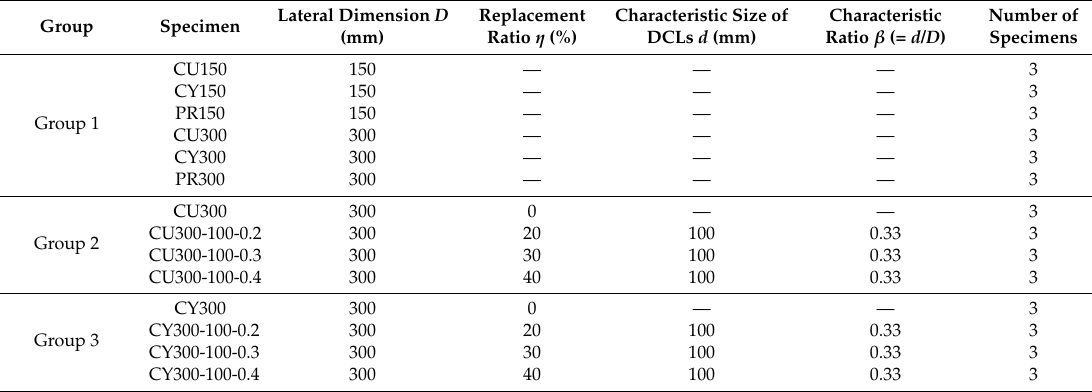
Table 2. Details of specimens.